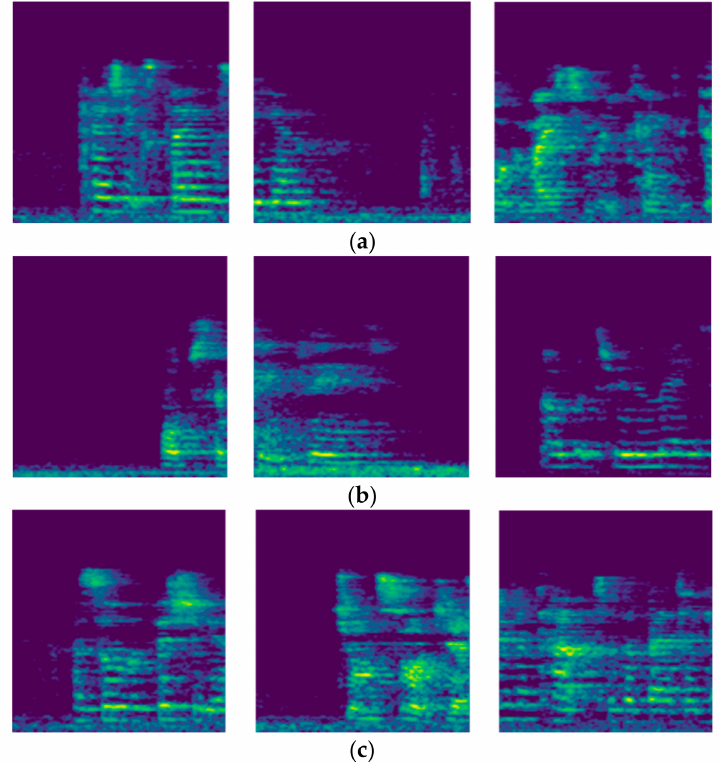
Figure 5. Random selections of the first-channel mel spectrograms. ( a ) Log-scaled mel spectrograms in the one-meter class; ( b ) Log-scaled mel spectrograms in the two-meter class; and ( c ) Log-scaled mel spectrograms in the three-meter